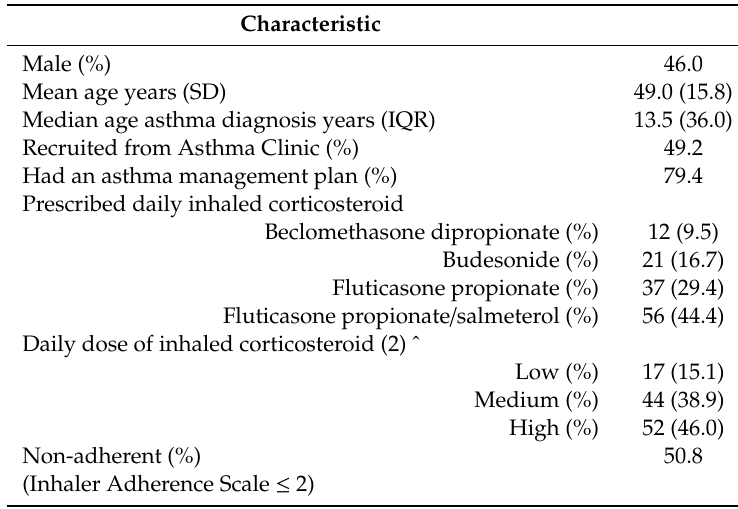
Table 1. Characteristics of the 126 participants who completed the study.